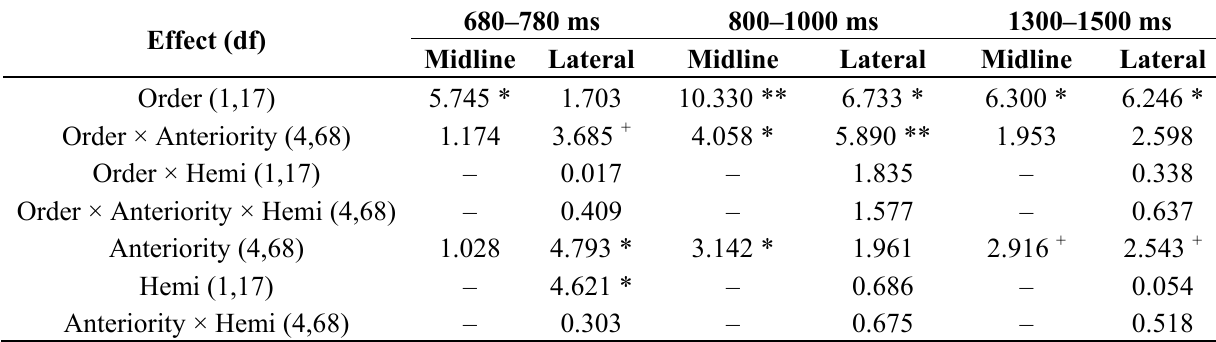
Table 9. First letter, results from ANOVA ( F -values) for the 680–780-ms (P2), 800–1000-ms and 1300–1500-ms (negativity) intervals.